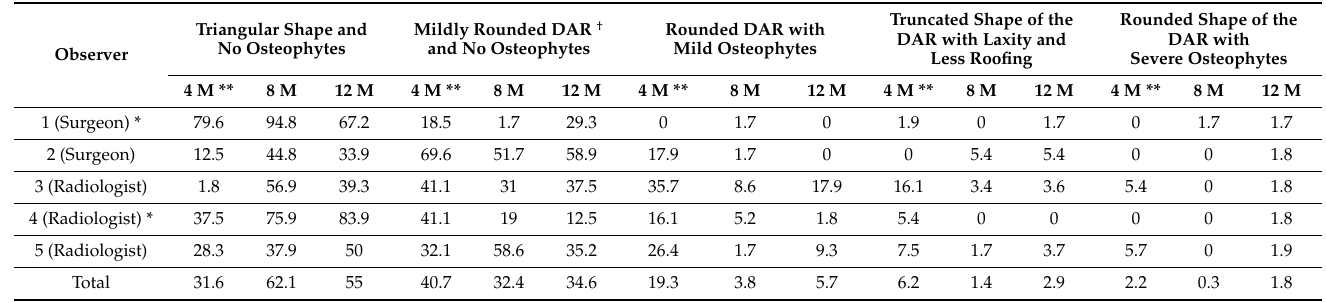
Table 6. Percentages (%) of evaluations of grading of dorsal acetabular rim (GDAR) by observers at 4 [29], 8, and 12 months of age.